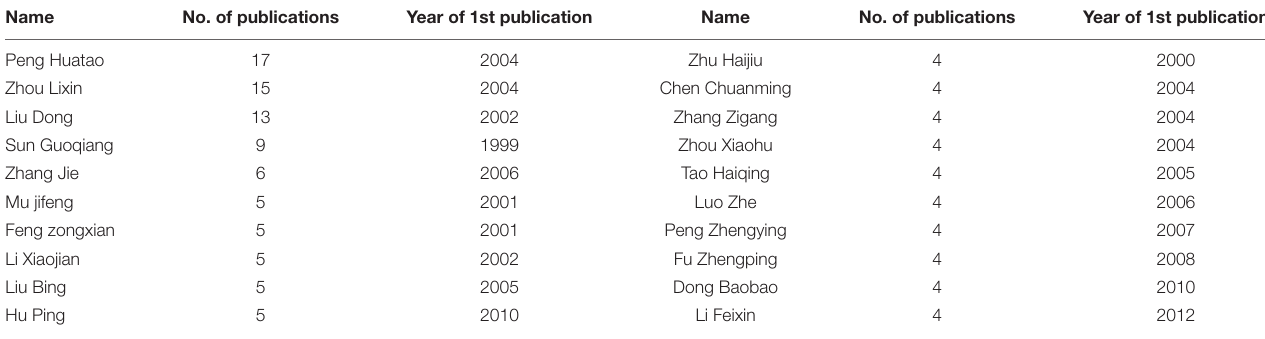
TABLE 2 | Core researchers of EN studies in